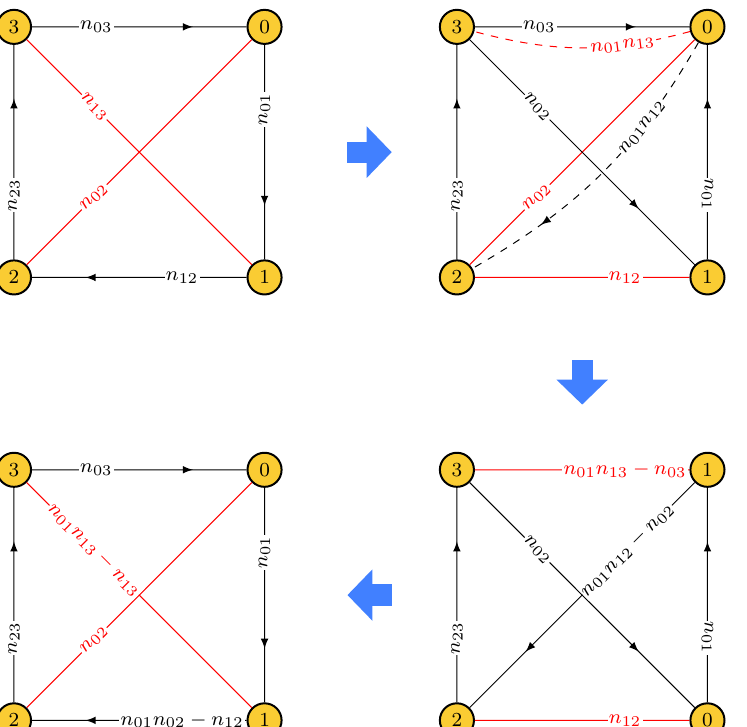
Figure 5. A mutation for C 4 = Z 4 . The (cid:12)rst (cid:12)gure is the original quiver. Mutating on node 1 we obtain the second quiver, where dashed arrows represent mesons. In the third step we integrated out massive (cid:12)elds and exchanged the labels of nodes 0 and 1. In the last step we switched the positions of nodes 0 and